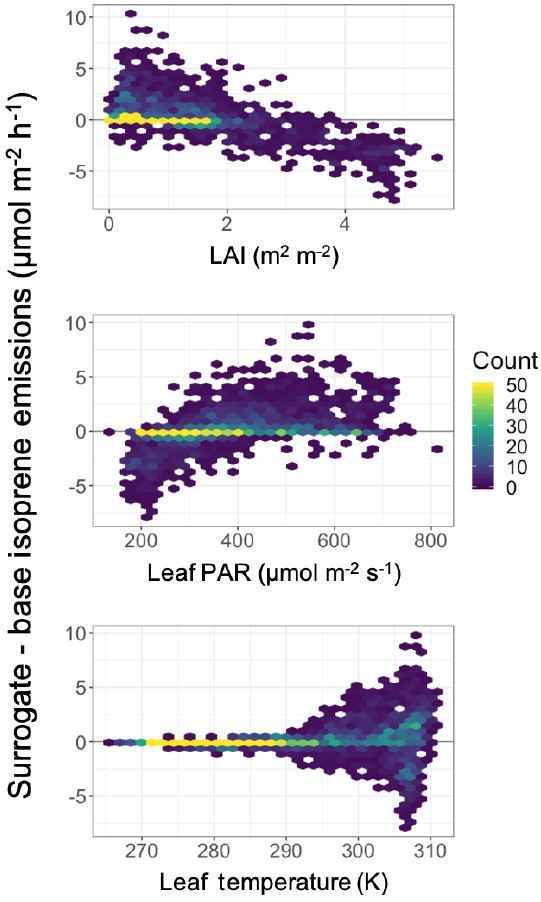
Figure 10. Difference in annual average isoprene emissions be- tween the surrogate canopy model (MEGAN Canopy ) and the base simulation (MEGAN PCEEA ) (atomsCcm − 2 s − 1 ; see Fig. 9b) as a function of LAI, leaf-level PAR (µmolm − 2 s − 1 ), and leaf tempera- ture (K). Grid boxes dominated by water were filtered and removed from these figures. The color bar represents the number of observa- tions in a given